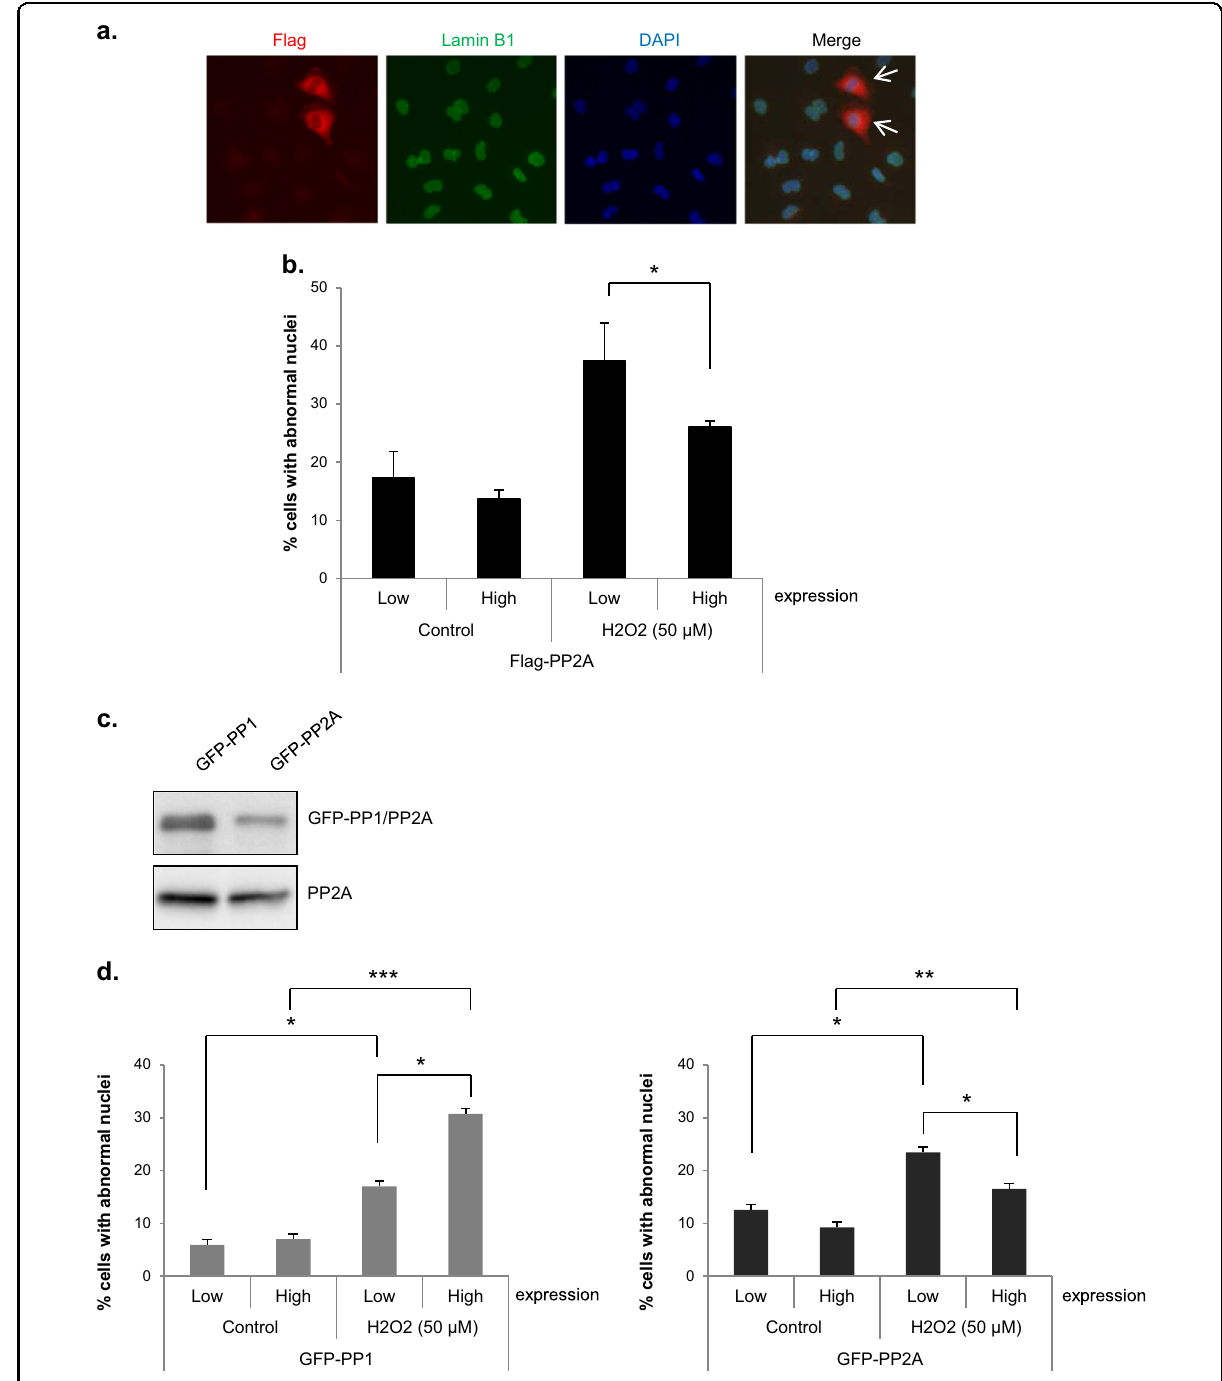
Fig. 5 Overexpression of PP2A but not PP1 rescued the H 2 O 2 -induced nuclear shape alteration. a , b HeLa cells were transfected with a Flag- PP2A expression vector, and mitotic cells were then treated with 50 μ M H 2 O 2 for 10 h. Representative image of mitotic cells expressing Flag-PP2A (red, arrow) after treatment with H 2 O 2 for 10 h. Lamin B1 (green) and DAPI (blue) ( a ). Percentage of cells with abnormal nuclear shapes according to Flag-PP2A expression. The results are shown as the means ± SDs of three independent experiments ( n = 100). * P < 0.05 by Student ’ s t -test ( b ). c , d HeLa cells were separately transfected with GFP-PP1 or GFP-PP2A expression vectors and mitotic cells were then treated with 50 μ M H 2 O 2 . Mitotic cell lysates were harvested and subjected to western blot analysis with an anti-GFP antibody (for PP1 or PP2A expression). PP2A; loading control ( c ). 10 h after H 2 O 2 treatment, the percentage of cells with abnormal nuclei according to GFP-PP1 or GFP-PP2A expression was determined. The results are shown as the means ± SDs of three independent experiments ( n = 100). * P < 0.05; ** P < 0.01; *** P < 0.001 by Student ’ s t -test ( d